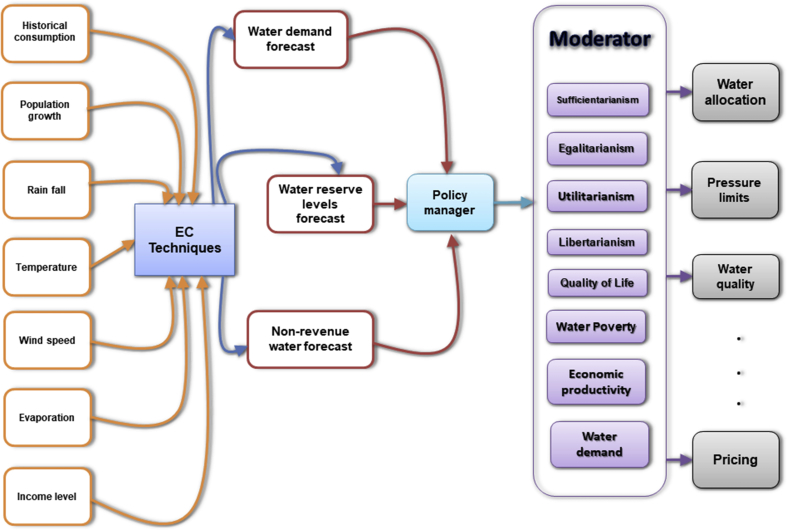
The proposed IWDMMF.